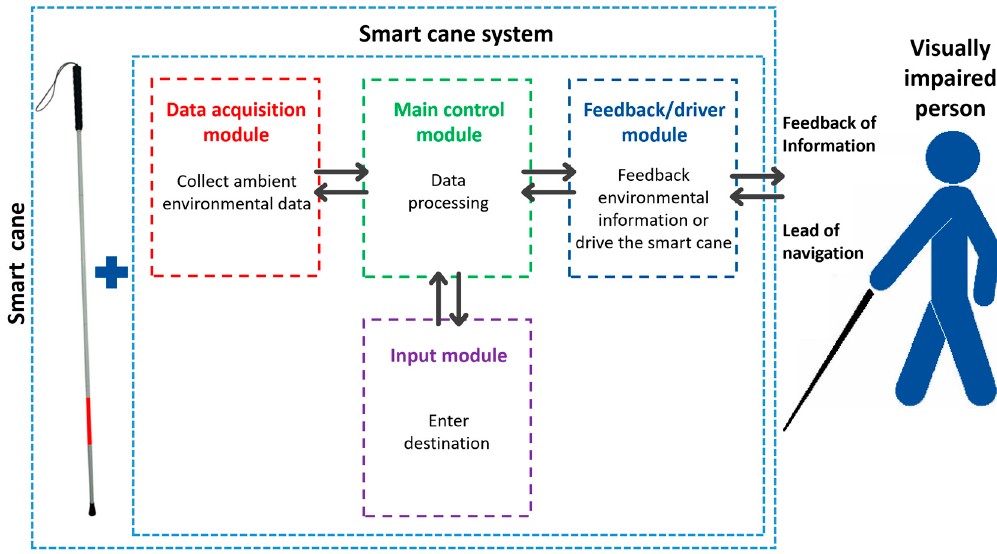
Figure 1. Structure diagram of smart cane .